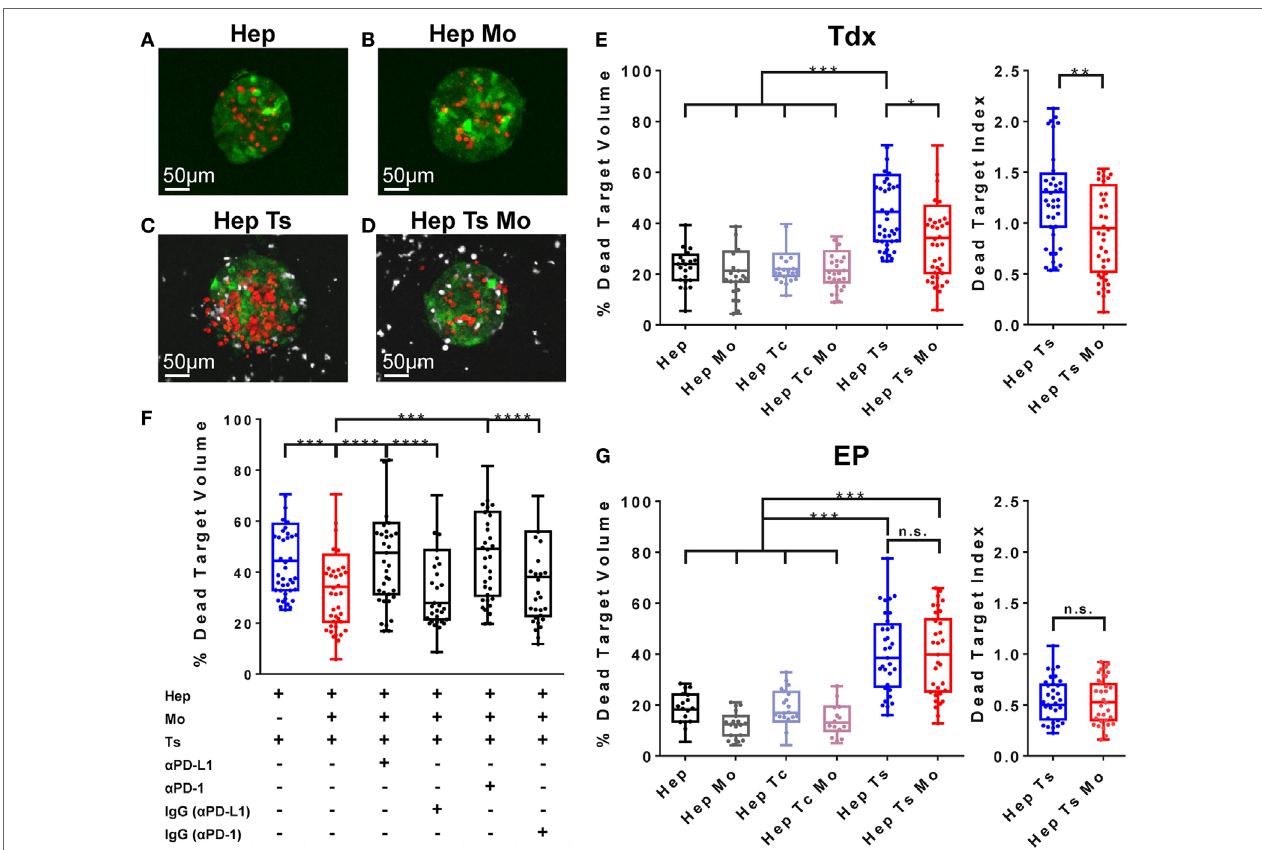
FigUre 5 | (a–D) Representative target cell aggregates of the conditions Hep (a) , Hep Mo (B) , Hep Ts (c) , and Hep Ts Mo (D) , in which the presence of dead target cells is DRAQ7 + (in red), HBV-specific TCR T cells are labeled with Cell tracker violet dye (in white), while monocytes are unlabeled. (e) Box plot of the percentage of dead target (HepG2-Pres1-GFP) volume after 24 h of co-culture with Tdx HBV-specific TCR T cells. Data in terms of a “Dead Target Index” are also shown where the percentage of dead target volume is normalized to the percentage of TCR + T cells. (F) Box plot of the percentage of dead target volume after 24 h of treatment with Tdx HBV-specific TCR T cells with or without PD-L1- or PD-1-blocking antibody or their respective isotype (IgG) controls. (g) Box plot of the percentage of dead target (HepG2-Pres1-GFP) volume after 24 h of co-culture with EP HBV-specific TCR T cells. Data in terms of a “Dead Target Index” are also shown. Data points reflect the measured values of individual target cell aggregates and collectively represent the pooled results of three donors, where the 25th, 50th, and 75th percentiles as well as minimum and maximum values are indicated. Bars are drawn where a comparison was made with * P ≤ 0.05, ** P ≤ 0.01, *** P ≤ 0.001, and **** P ≤ 0.0001. Statistical significance was evaluated by a one-way ANOVA with Holm-Sidak’s multiple comparisons test. EP, mRNA-electroporated; HBV, hepatitis B virus; Hep, HepG2-preS1-GFP; Mo, monocyte; n.s., not significant; Tc, control T cell; TCR T cells, T